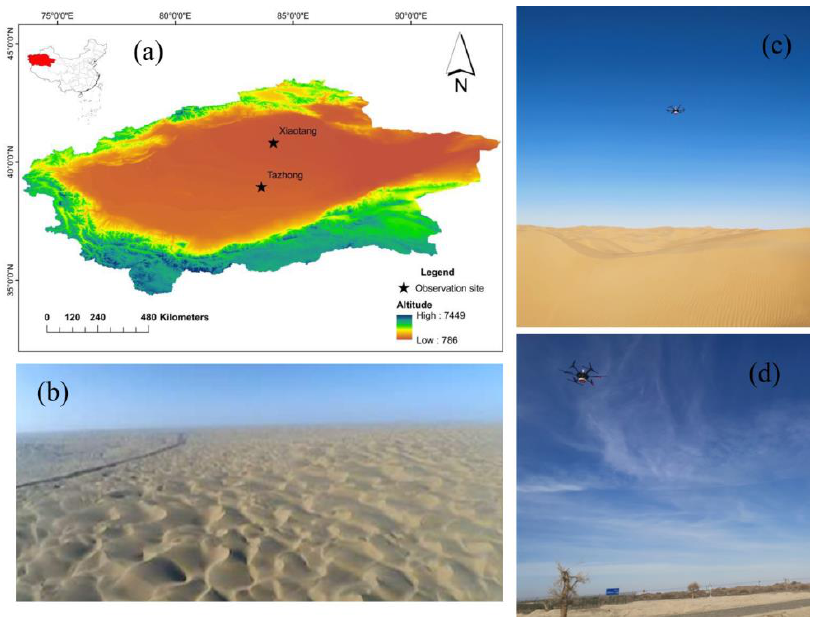
Figure 1. ( a ) Sites of the UAV observations; ( b ) a typical image obtained with the UAV. Pictures of the UAV flying over ( c ) Tazhong and ( d ) Xiaotang.